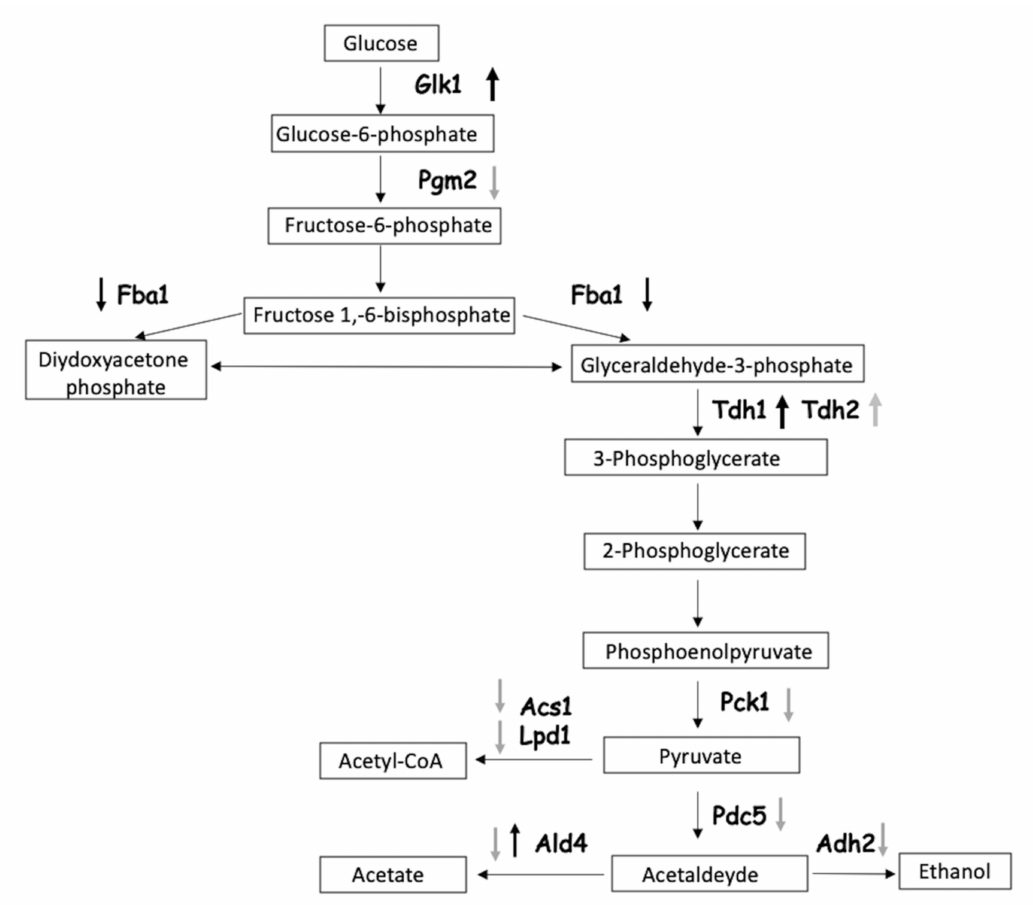
Figure 6. Glycolysis and gluconeogenesis pathway. Black arrows are for the proteins found, with iTRAQ, after 9 h treatment, grey arrows are for the proteins found after 24 h treatment. Arrows pointing up indicate upregulated proteins, arrows pointing down indicate downregulated